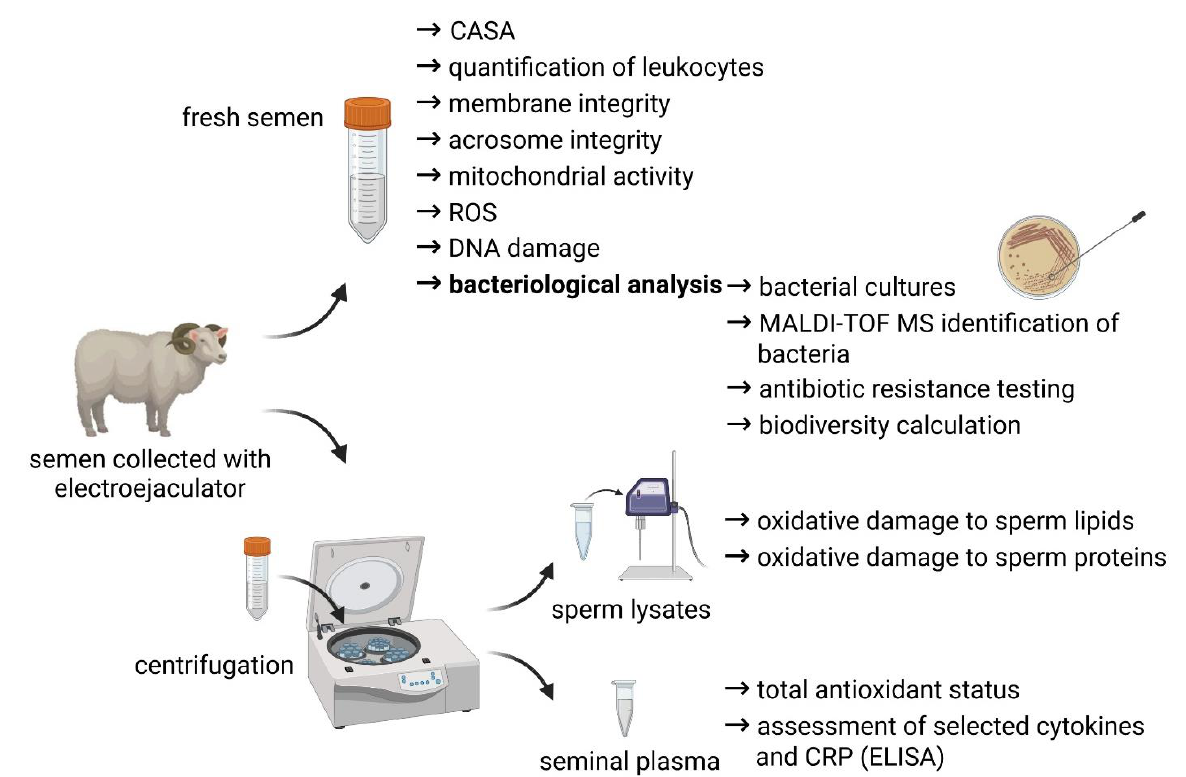
Figure 1. Experimental outline of the study.